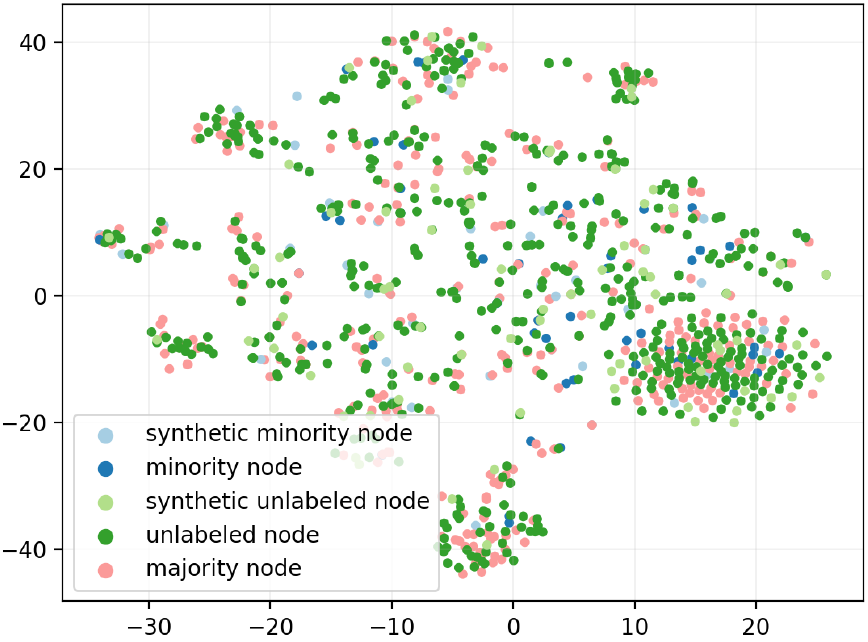
Figure 9. A t-SNE visualization of synthetic and real node features of the F LICKR dataset obtained from SORAG F . The node colors denote the